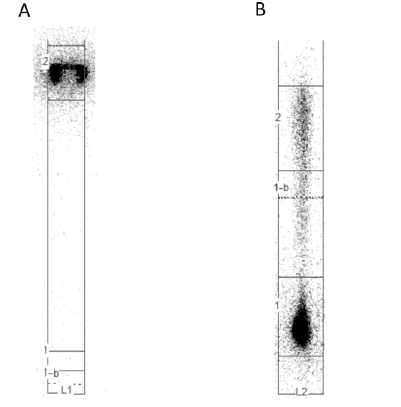
Figure 8. HPLC analysis of reaction mixtures after synthesis of [ 68 Ga]Ga-NODAGA-Glu-CFM (gra- dient 2) and the ‘cold’ reference compound Ga-NODAGA-Glu-CFM (270 nm, gradient 2) .